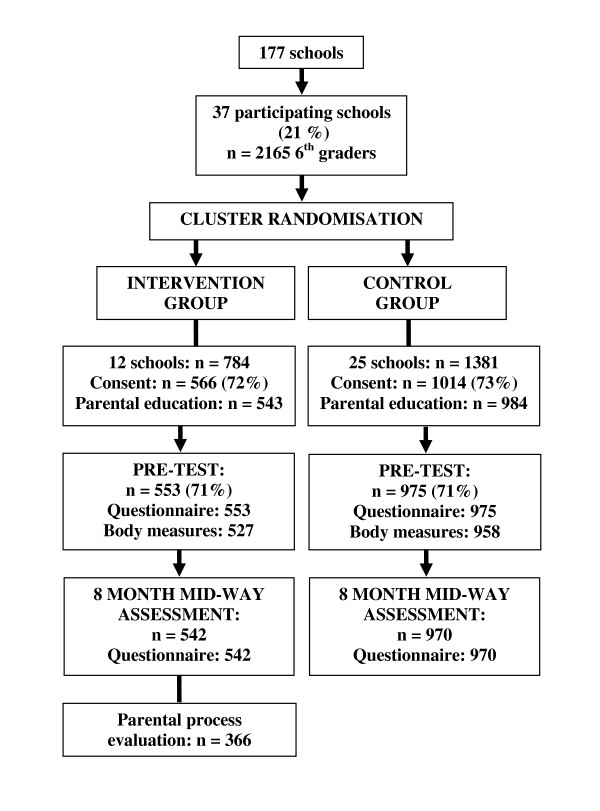
Flow diagram of recruitment, randomization and participation of adolescents and parents in the HEIA study.